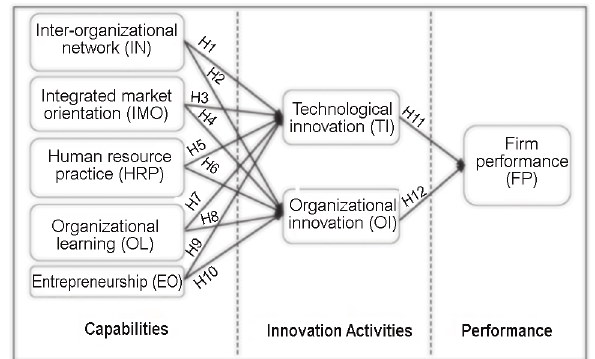
Figure 1. Research model on innovation development for